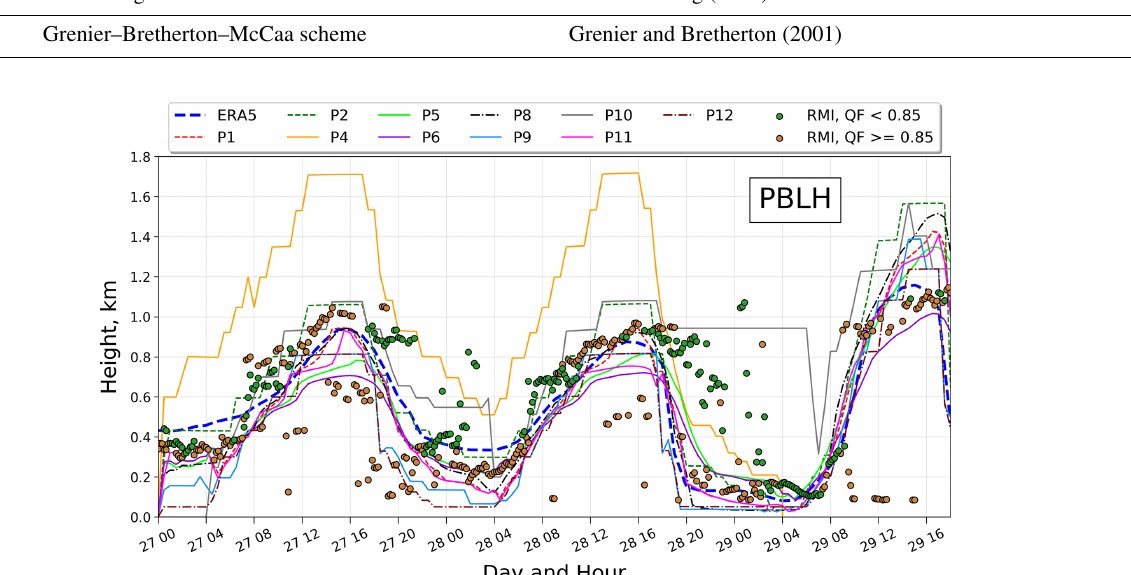
Figure 6. Time series of measured and modeled PBL height between 27 and 29 June 2019 (average of two sites). Good-quality measurements (QF < 0 . 85) are shown as green dots and low-quality data (QF > 0 . 85) as brown dots. The dark blue dashed line is the PBL height from the ERA5 reanalysis (Hersbach et al., 2020). The other curves represent the WRF model output for each of the boundary layer schemes listed